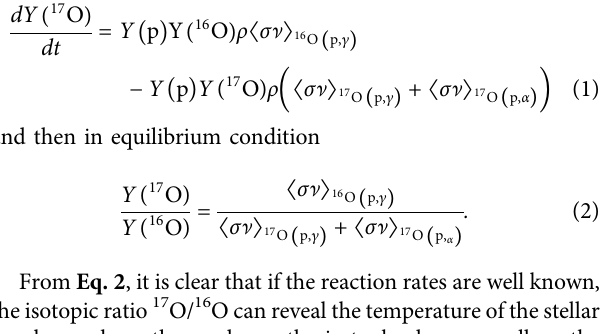
16 O( p , γ ) 17 F reaction only in the inner and hotter layers of the H-burning shell, while the 17 O+ p reaction rate has not a linear or monotonic dependence with temperature. It turns out that in the